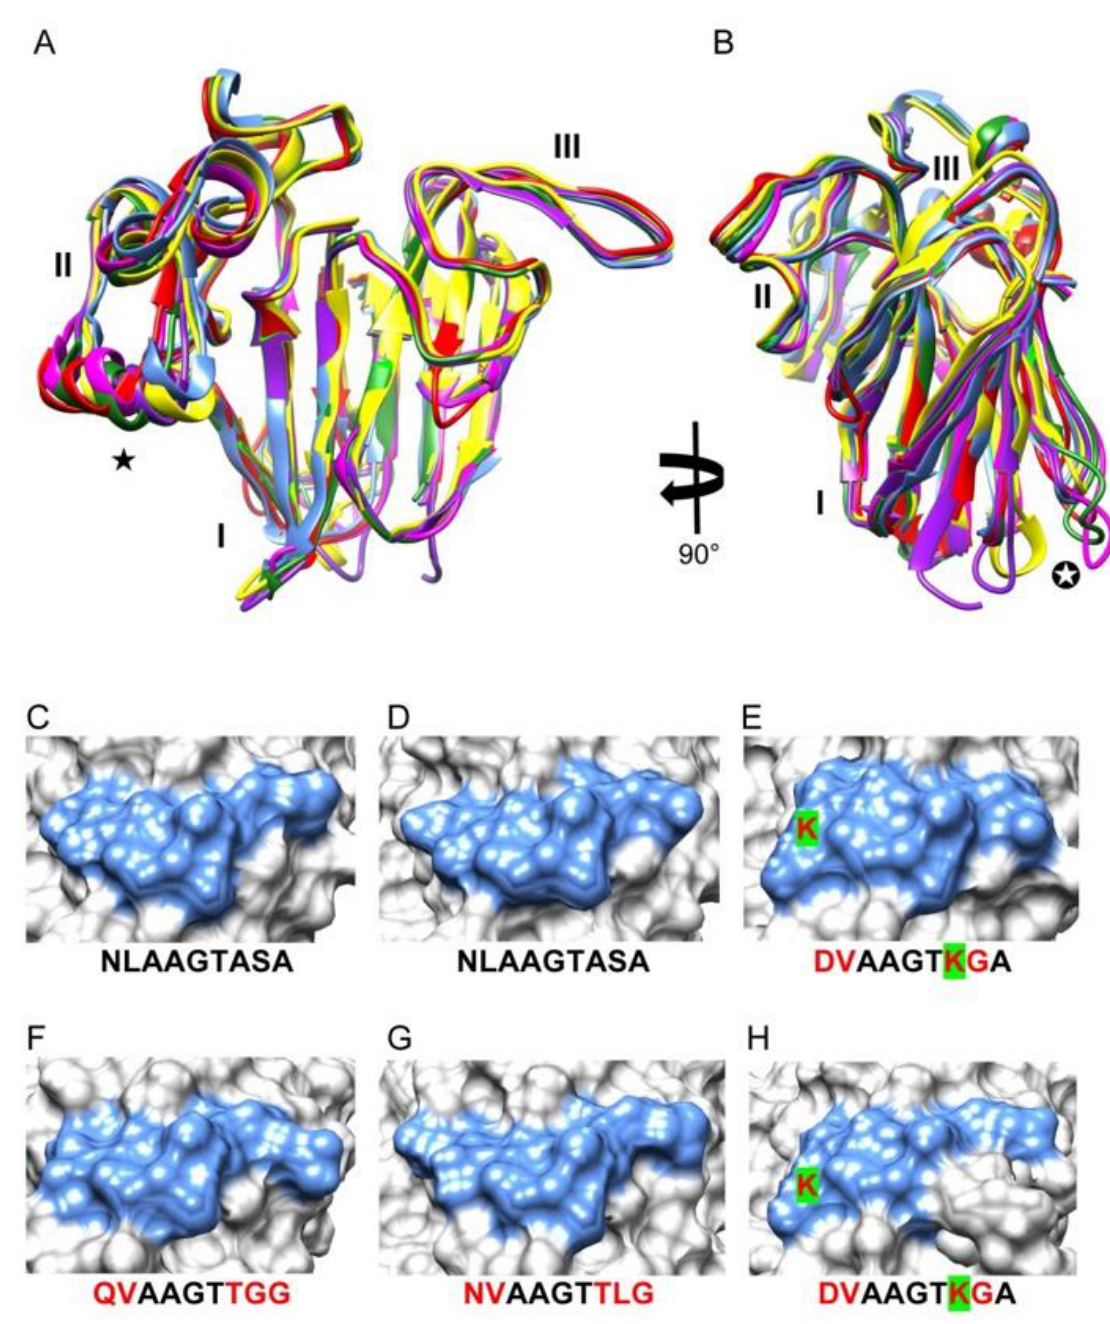
Figure 4. Front view ( A ) and lateral view ( B ) of the superimposed ribbon diagrams of Cup s 3 (red),